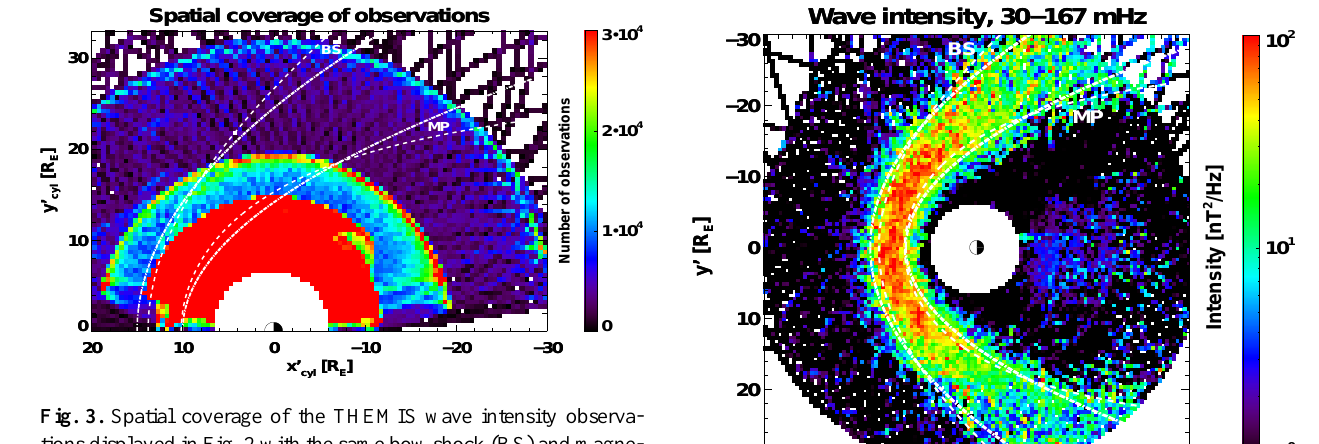
Spatial coverage of observations